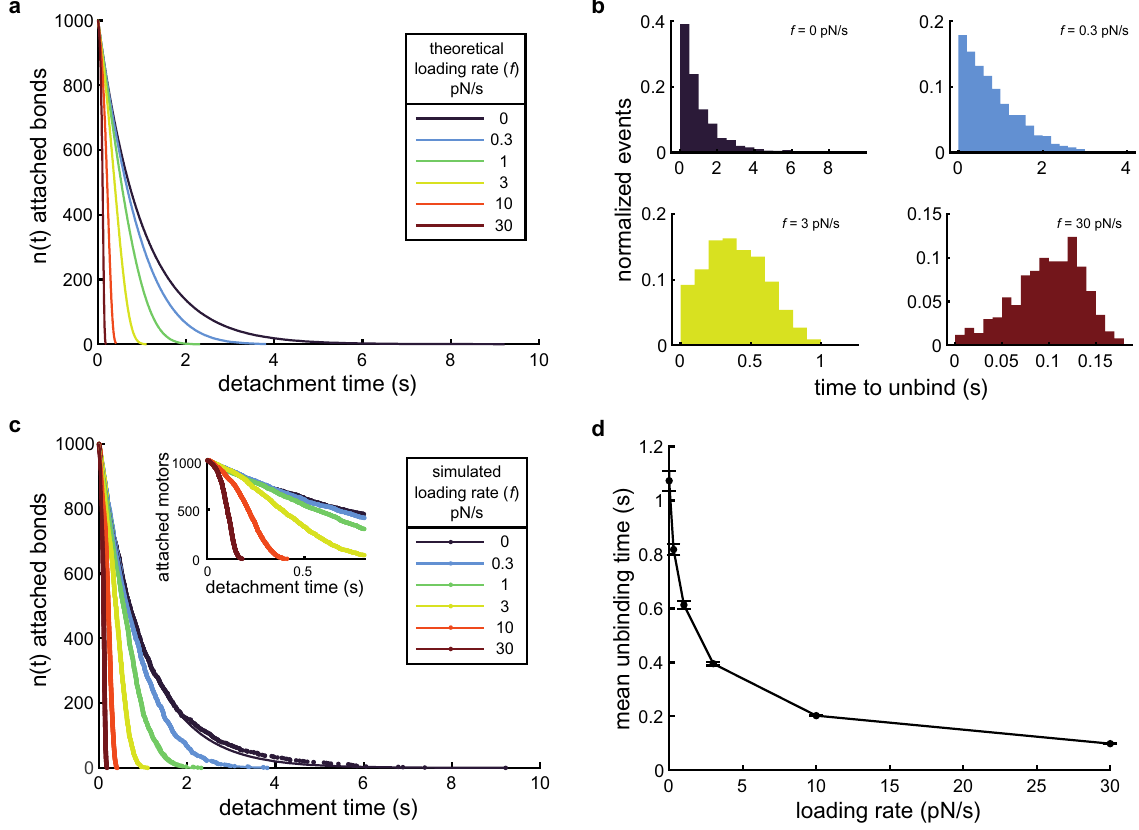
Figure 3. Calculating the force-dependent unbinding rate for slip bonds. ( a ) n ( t ) = Ne − k 0,s t plotted for no loading ( dark purple line ) and Eq. (5) plotted for various loading rates ( colored lines ) with N = 1000 slip bonds that have an unloaded unbinding rate k 0, s = 1 s −1 and force sensitivity F s = 1 pN. ( b ) Histograms of the time to unbind from a typical, N = 1000 , slip bond simulation with parameters as in panel ( a ) for various loading rates, as indicated. ( c ) Number of bound slip bonds as a function of time from example simulations at various loading rates, as indicated. Inset shows detail highlighting the characteristic shape of n ( t ) for higher loading rates (3 pN/s yellow , 10 pN/s orange , and 30 pN/s dark red ). The data ( dots ) were fitted to n ( t ) = Ne − k 0,s t for f = 0 ( dark purple line ) and Eq. (5) for the others ( lines ). In both cases, see Table S2 for the fit parameters. The same example simulation data were used as in panel ( b ), where applicable. ( d ) Mean unbinding time of 50 simulations, with N = 1000 slip bonds each, as a function of loading rate. The error bars represent